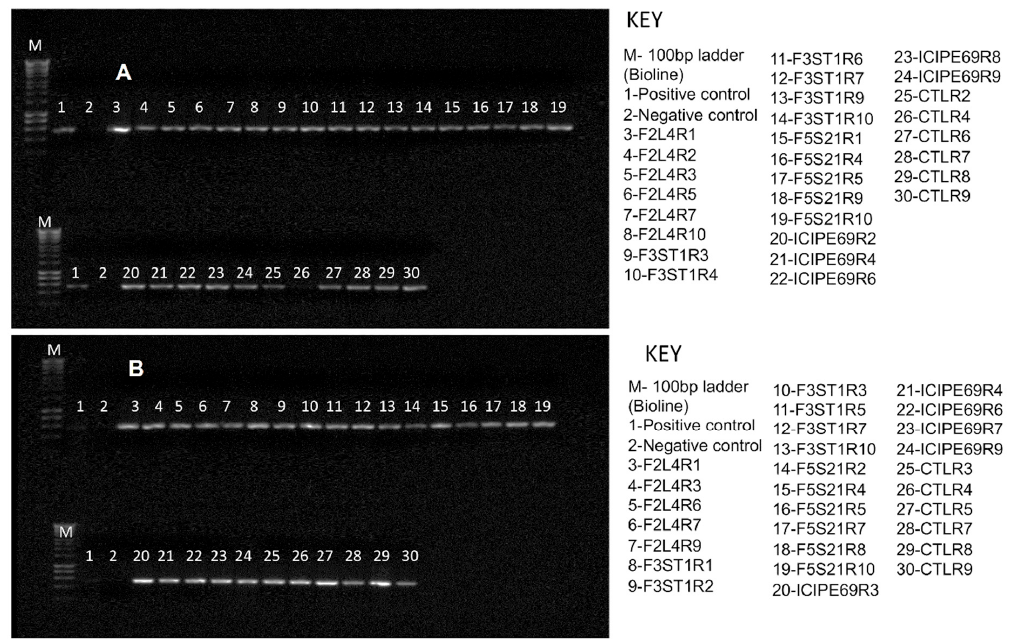
Figure 6. RT-PCR detection of Maize chlorotic mottle virus (MCMV) in leaf samples of various treatments at 14 days post inoculation. Gels for trials one ( A ) and two ( B ) are presented. F2L4, F3ST1, F5S21 and ICIPE69 represent the fungal endophytes, while R1–R10 represent the replicates that were randomly selected for evaluation.